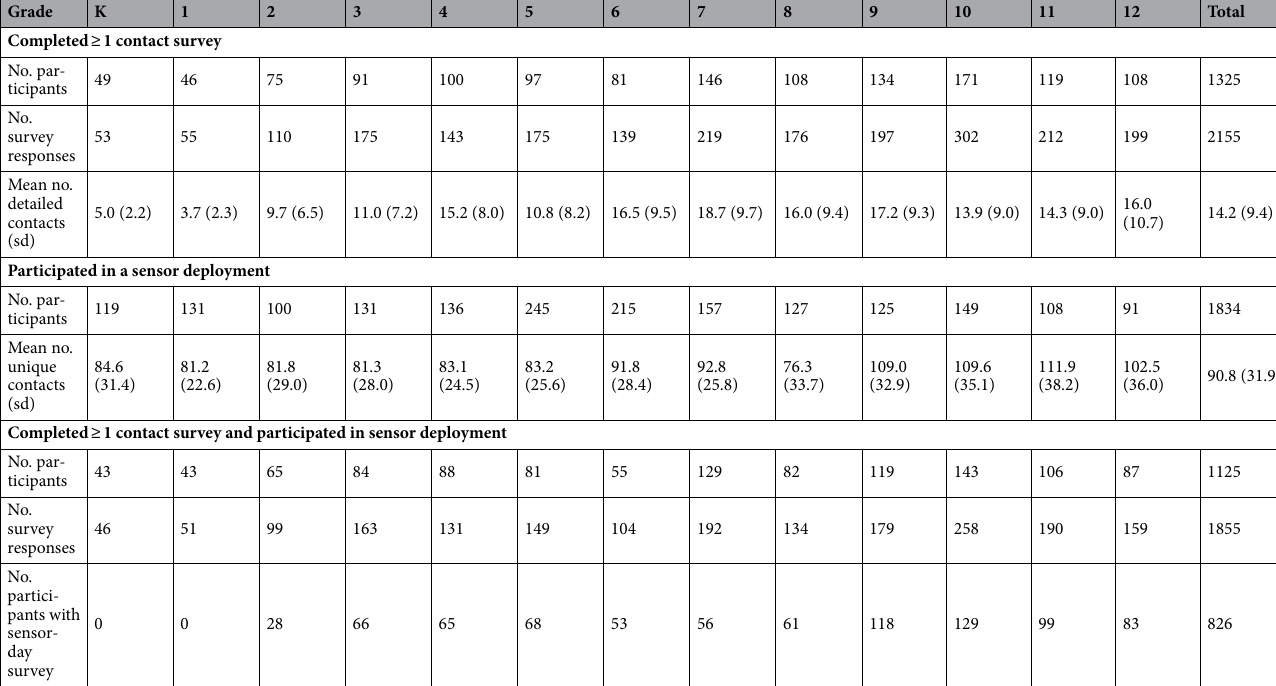
Table 1. Study population and average number of contacts recorded by self-reported contact surveys and proximity-detecting sensors in a US school setting. Detailed survey-reported contacts are those interactions for which a student also reported contact age, sex, duration, and context. Unique sensor-recorded contacts for each participant is the total number of other participants with whom their proximity sensor recorded at least one interaction during a sensor deployment. Sd standard deviation.